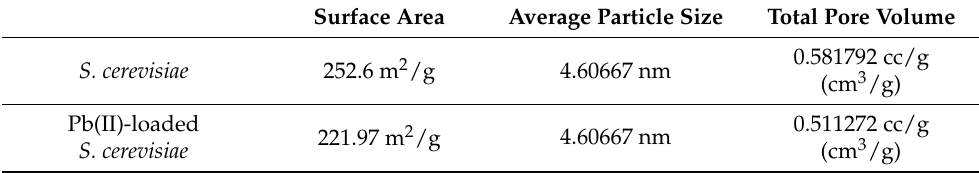
Table 6. Brunauer–Emmett–Teller (BET) analysis for raw and Pb(II)- S. cerevisiae biomass.